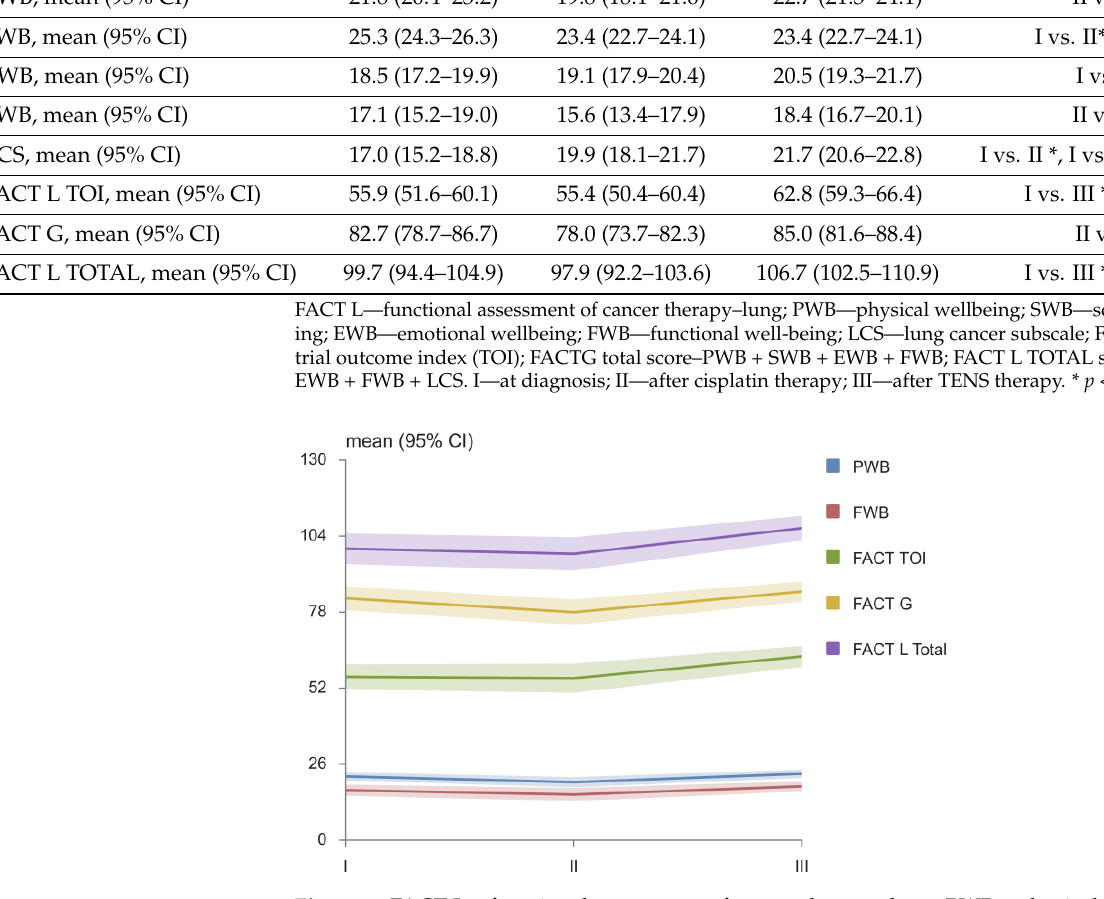
Figure 2. FACT L — functional assessment of cancer therapy – lung; PWB — physical wellbeing; Figure 2. FACT L—functional assessment of cancer therapy–lung; PWB—physical wellbeing; FWB—